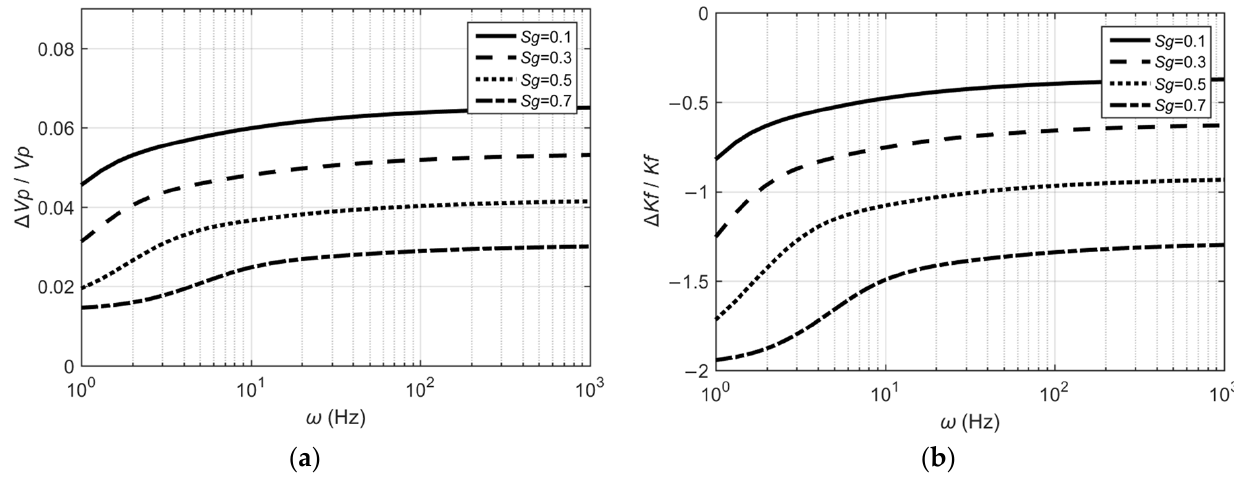
∆ K P / V P and ( b ) f / K f varying with frequency for different S g